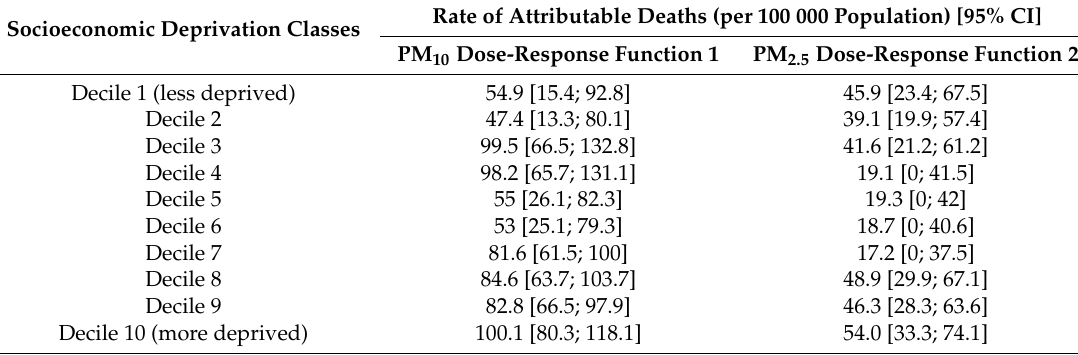
Table 6. Rate of attributable deaths per socioeconomic class for two dose-response function. Socioeconomic Deprivation